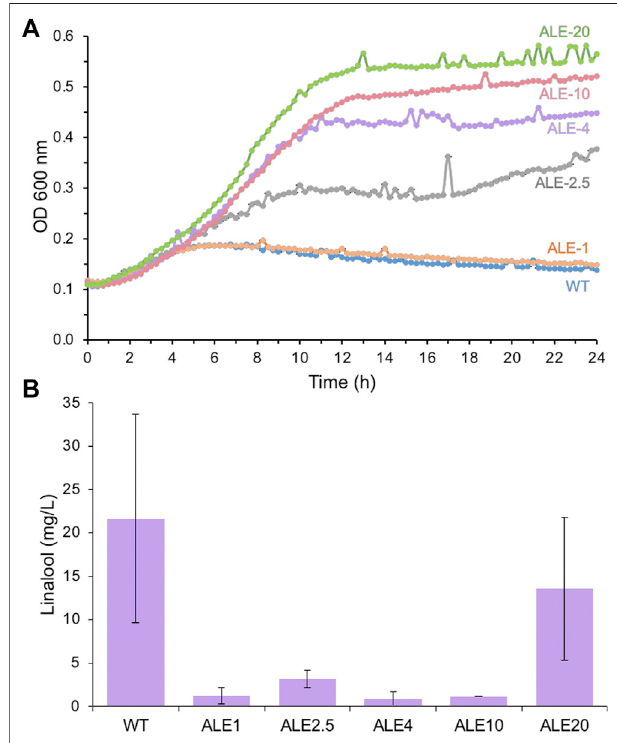
FIGURE 3 | Growth (A) and linalool production. (B) of wild-type E. coli DH5 α and adapted laboratory evolution (ALE) strains in the presence of linalool. Replicate aliquots of an overnight E. coli DH5 α culture (200 μ L) were set up in LB medium containing 10 g/L linalool in a sealed 96-well microtiter plate and incubated at 30 ° C with 500 rpm agitation within a microplate reader. Optical density readings (OD 600 nm ) were performed every 15 min for 24 h. E. coli strains: WT (DH5 α ) = blue; ALE-1 = orange; ALE-2.5 = grey; ALE-4 = purple; ALE-10 = red; ALE-20 = green. Evolved linalool tolerant strains ALE 1, 2.5, 4 10 and 20 were transformed with pMVA-GLinS NR2 and assayed for linalool production as described in Figure 2 . Error bars represent one standard deviation of the average of up to 3 individual data